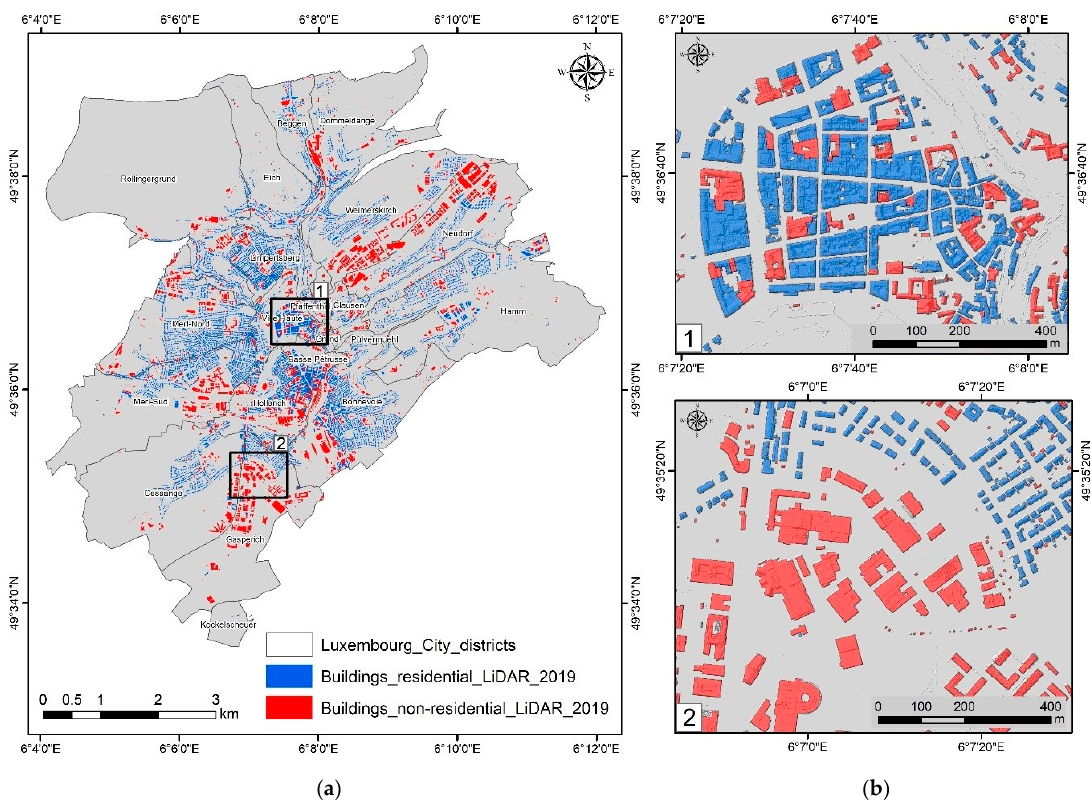
Figure 10. Residential and non-residential buildings based on ALS point cloud (2019) and cadastral data in Luxembourg City ( a ); ( b ) Ville Haute as a residential district (at the right top, b-1), and Gasperich a non-residential part (at the right bottom, b-2).